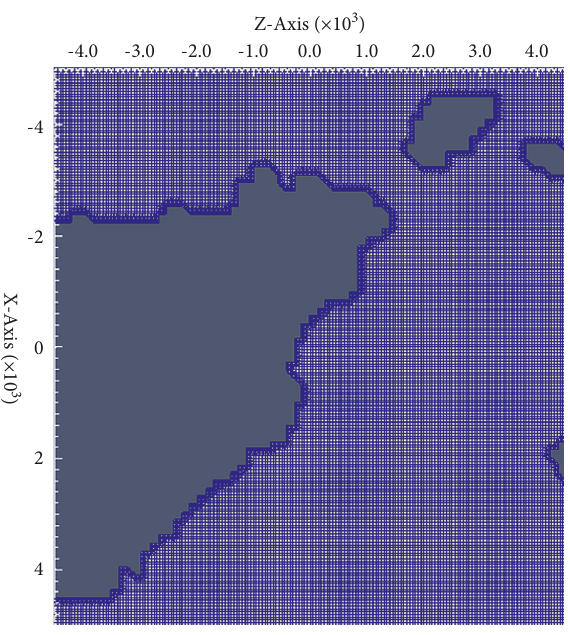
Figure 5: Grids of terrain in DBA. Table 2: Hydrological data of Daya Bay in July and